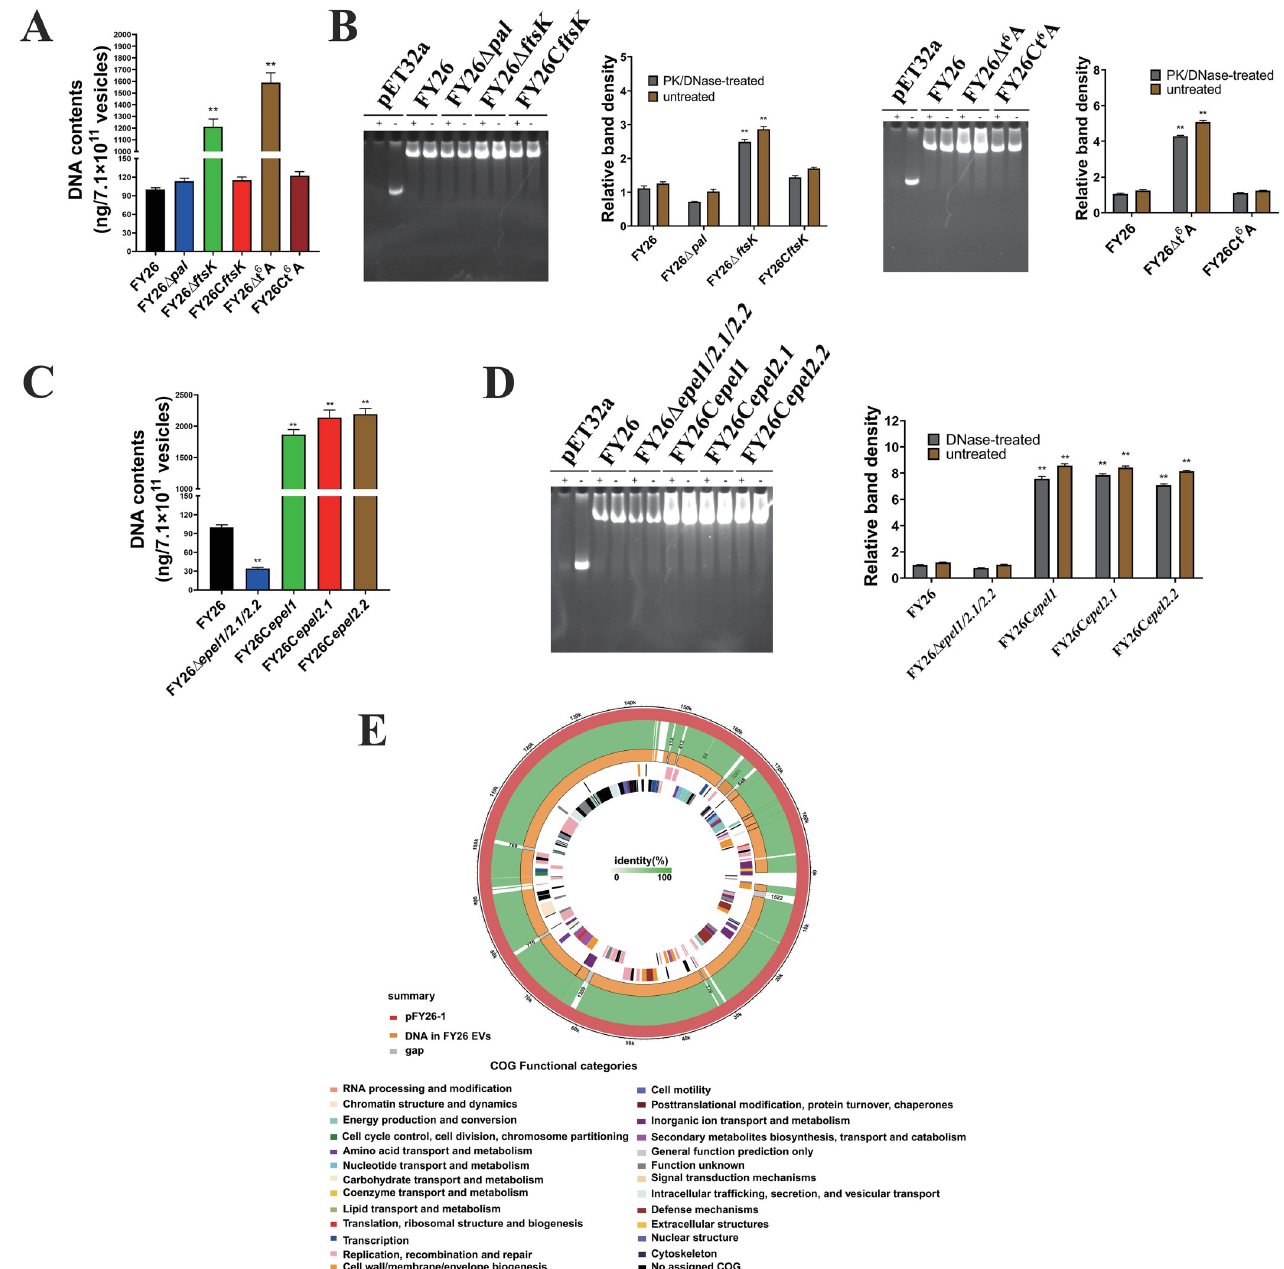
Fig 11. Proportion of cytoplasm-carrying vesicles affects the DNA content carried by ExPEC EVs. (A) Total DNA in EVs was measured with microplate reader. Total DNA was extracted from equivalent numbers of EVs (7.1 × 10 11 vesicles) from FY26, FY26 Δ pal , FY26 Δ ftsK , FY26C ftsK , FY26 Δ t6A, and FY26Ct6A were measured with microplate reader. Data were obtained from at least three independent experiments, with three replicates. Statistical significance was evaluated with one-way ANOVA ( �� P < 0.01). (B) Total DNA in the EVs (FY26, FY26 Δ pal , FY26 Δ ftsK , FY26C ftsK , FY26 Δ t6A, and FY26Ct6A) was visualized with nondenaturing polyacrylamide gel electrophoresis. Total DNA was isolated from equivalent numbers (7.1 × 10 11 ) of PK/ DNase-treated and untreated EVs from wild-type (WT) strain FY26 and several mutants. ‘+’ indicates that samples were treated with PK and DNaseI, and ‘ − ’ indicates that samples were not treated with PK or DNaseI. Naked DNA (pET-32a) was used as a control. (C) Total DNA in EVs was measured with microplate reader. Total DNA was extracted from equivalent numbers of EVs (7.1 × 10 11 vesicles) from WT FY26, triple-deleted mutant FY26 Δ epel1 / 2 . 1 / 2 . 2 ,and endolysin-overexpressing complemented strains FY26C epel1 , FY26C epel2 . 1 ,and FY26C epel2 . 2 , and measured with microplate reader. (D) Total DNA in EVs was visualized with nondenaturing polyacrylamide gel electrophoresis. Total DNA was extracted from equivalent numbers of EVs (7.1 × 10 11 vesicles) from WT FY26, triple-deleted mutant FY26 Δ epel1 / 2 . 1 / 2 . 2 , and endolysin-overexpressing complemented strains FY26C epel1 , FY26C epel2 . 1 ,and FY26C epel2 . 2 ,and analyzed with nondenaturing polyacrylamide gel electrophoresis. Naked DNA (pET-32a) was used as a control. (E) Circular maps of the complete plasmid